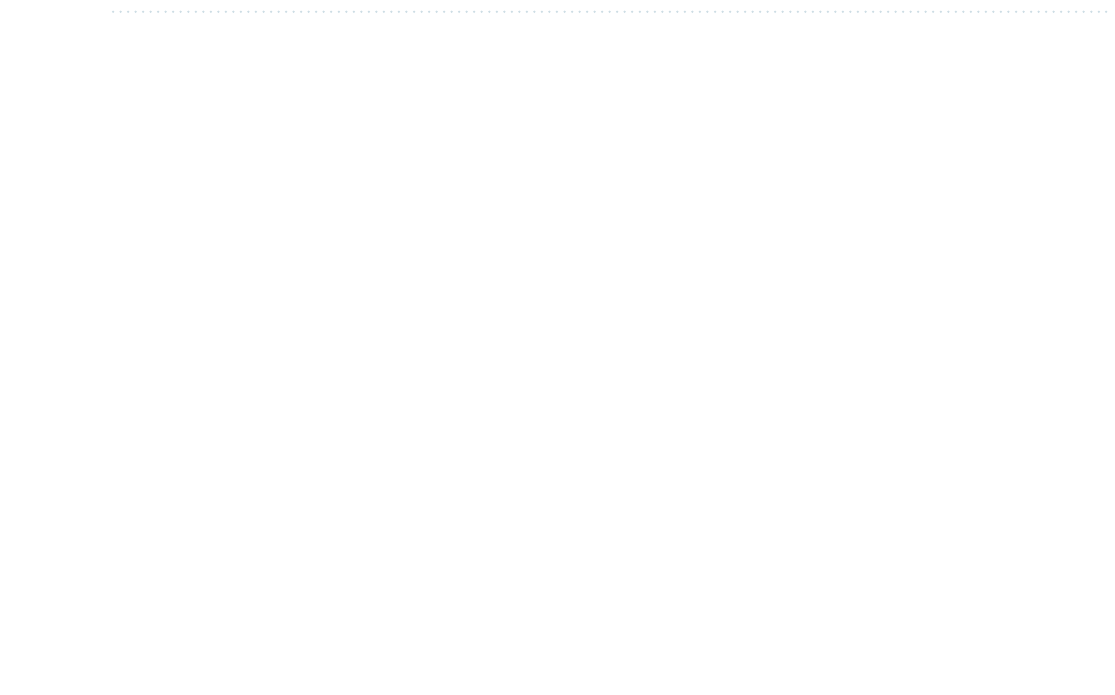
Figure 9. Comparison of power responses under different steady state power, ( a ) 100%, ( b ) 90%, ( c )